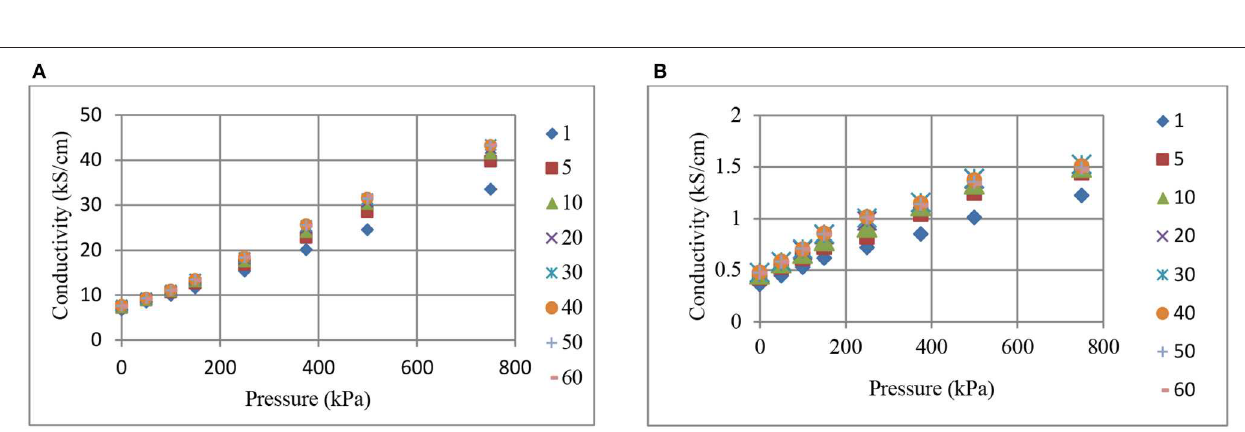
FIGURE 4 | The variation of resistivity, at 0 kPa (A) , and 750 kPa (B) pressure, with composition, for CB-NR composites measured at different times (min, inset right).